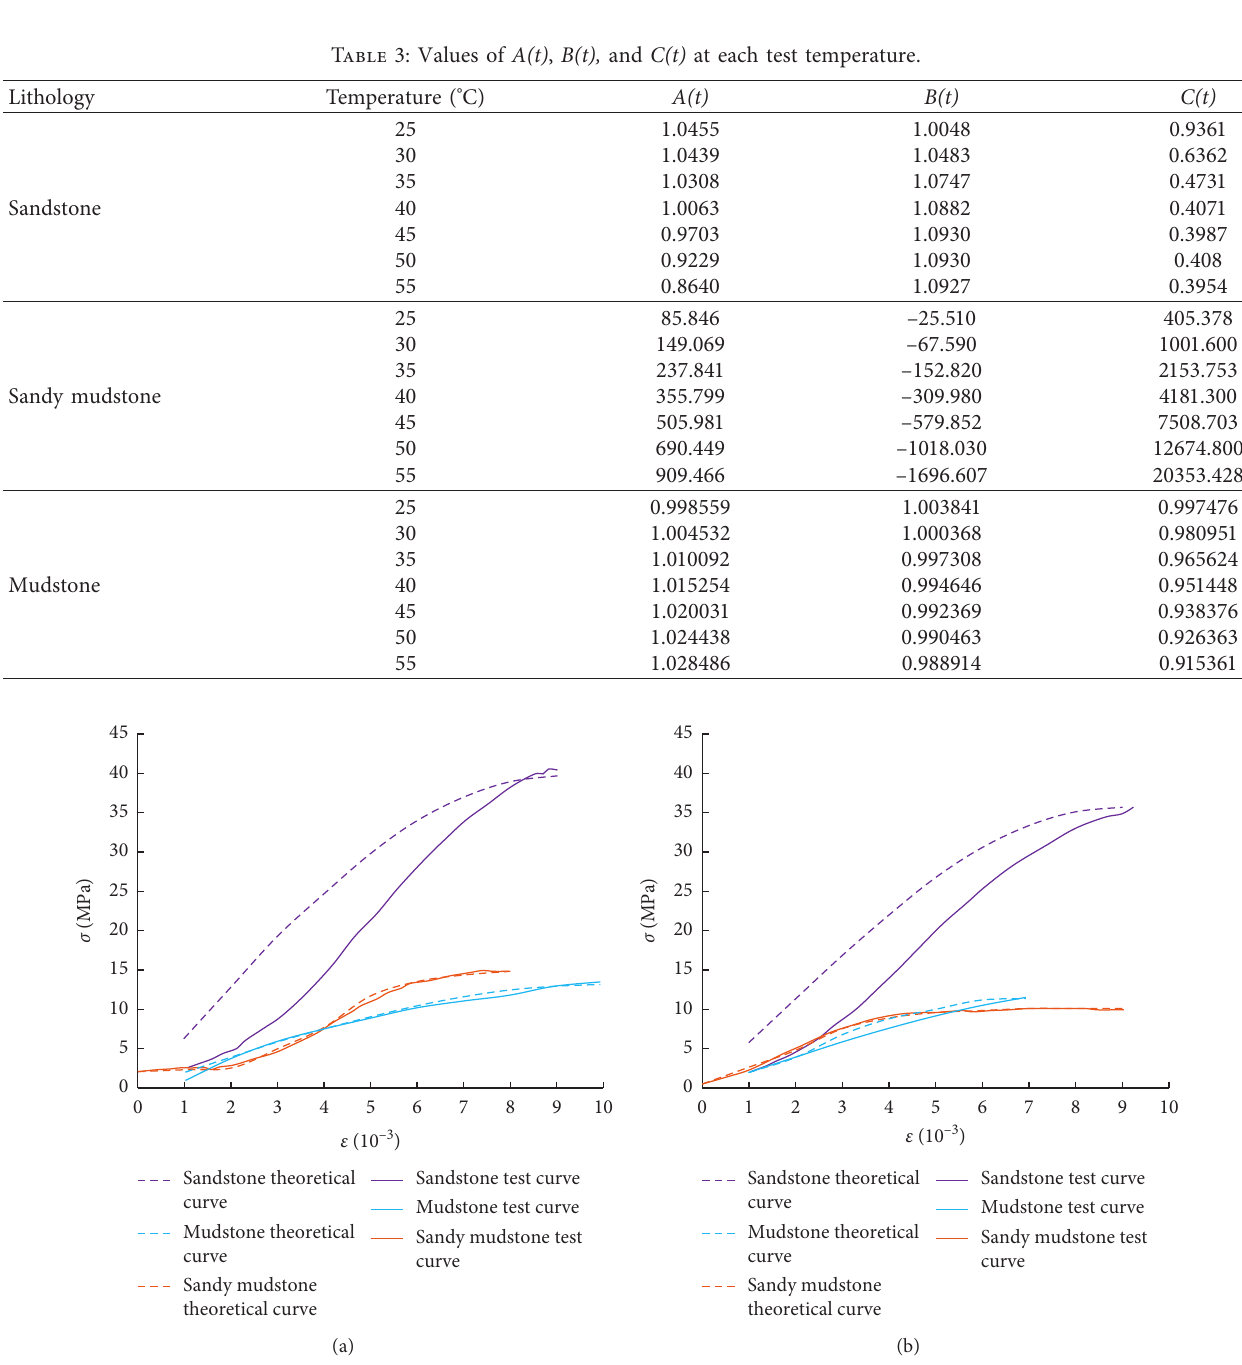
Figure 7: Comparison of the theoretical curve and the experimental curve before peak: (a) 35 ° C and (b) 55 °